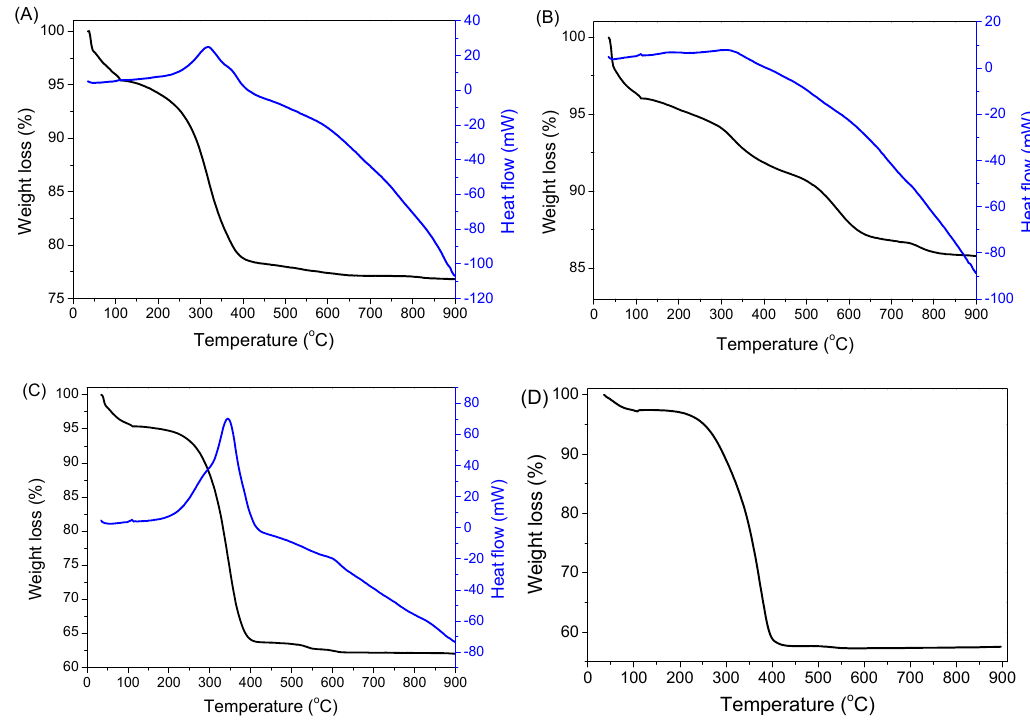
Figure 6. Thermogravimetric analysis (TGA) curves of Fe 3 O 4 /C/Mn hybrid: ( A ) Mn/MCS-R; ( B ) Mn/MCS-I; and ( C ) Mn/MCS-H ( D ) TGA curve of MCS.